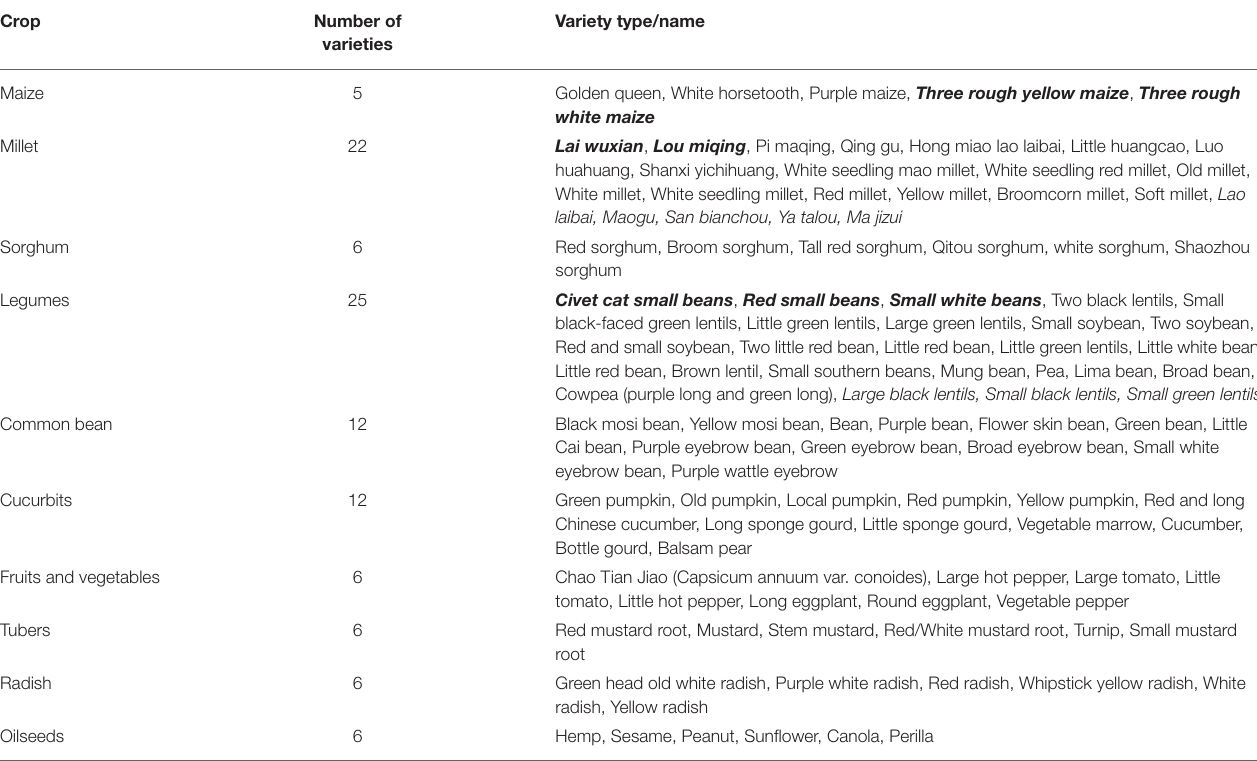
TABLE 5 | Commonly grown crop varieties and traditional varieties of Wangjinzhuang village. Crop Number of Variety varieties